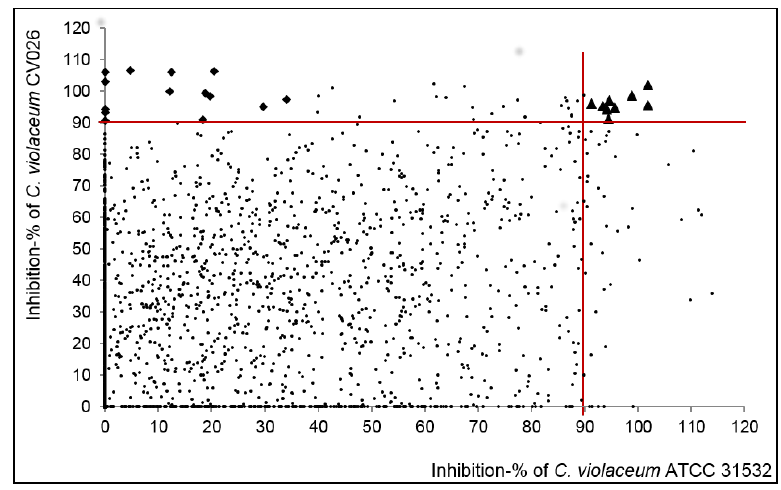
Figure 2. Inhibition of violacein production in C. violaceum ATCC 31532 and CV026 by the non-bactericidal compounds identified in primary screening ( n = 2399). Highly active QSIs are marked with black triangles and QQs with black diamonds. Complete results of the primary screening are presented in Table S2. The red lines indicate the thresholds of 90% inhibition of violacein production, which were set to identify the highly active inhibitors from the rest of the screened compounds.